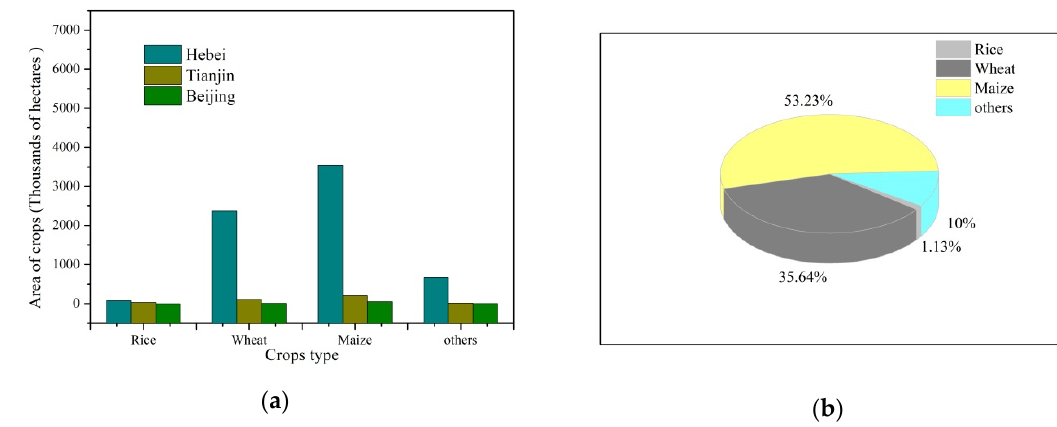
Figure 3. The cultivated area of crops in the B-T-H region in 2017. ( a ) The cultivated area of maize, wheat, rice, and crops total in Hebei, Tianjin, and Beijing, respectively. ( b ) The cultivated area of maize, wheat, rice, and crops total in Hebei (source: http://www.stats.gov.cn/).